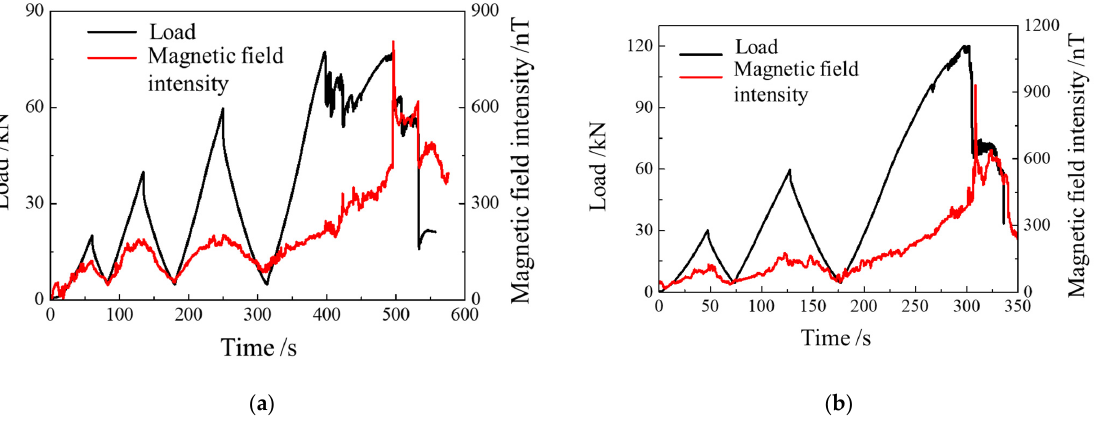
Figure 9. Variation law of the magnetic field of cyclic loading and unloading of concrete samples. ( a ) Sample c1, ( b ) Sample c2.